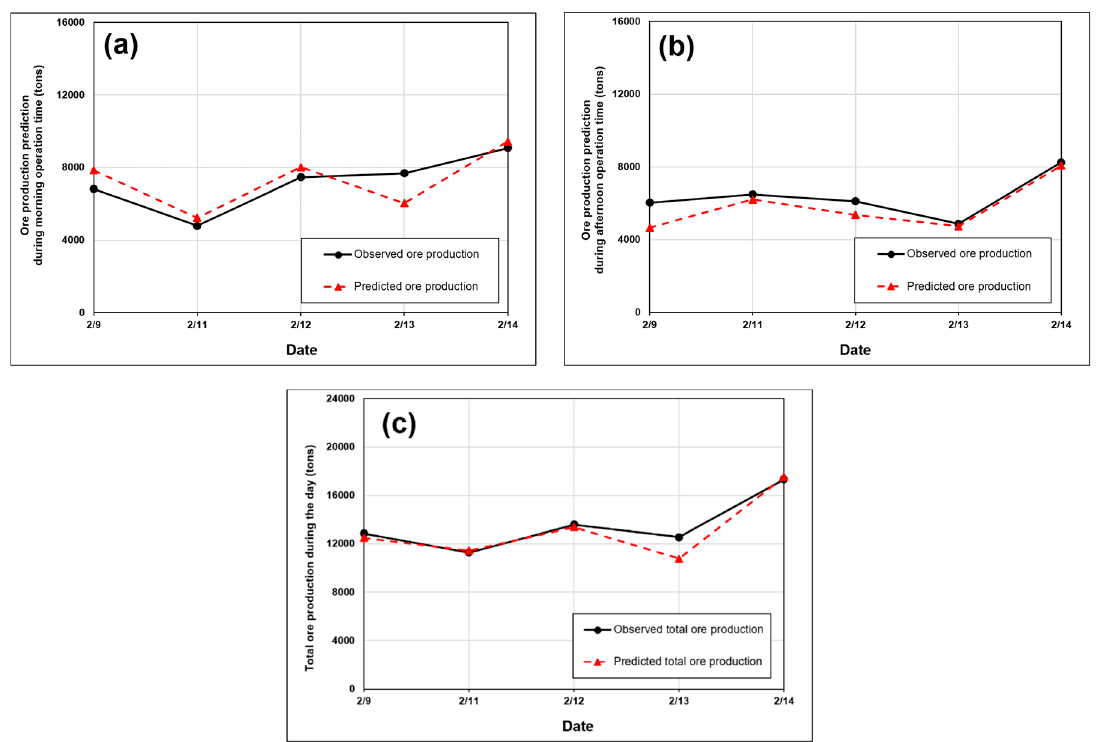
Figure 11. Inference results obtained using optimum DNN models: ( a ) Ore-production prediction during morning operation (tons); ( b ) ore-production prediction during afternoon operation (tons); ( c ) total ore production in a day (tons). Table 10. Prediction error between predicted and actual ore productions during five working days. Percentage Error (%) for Ore Production Date